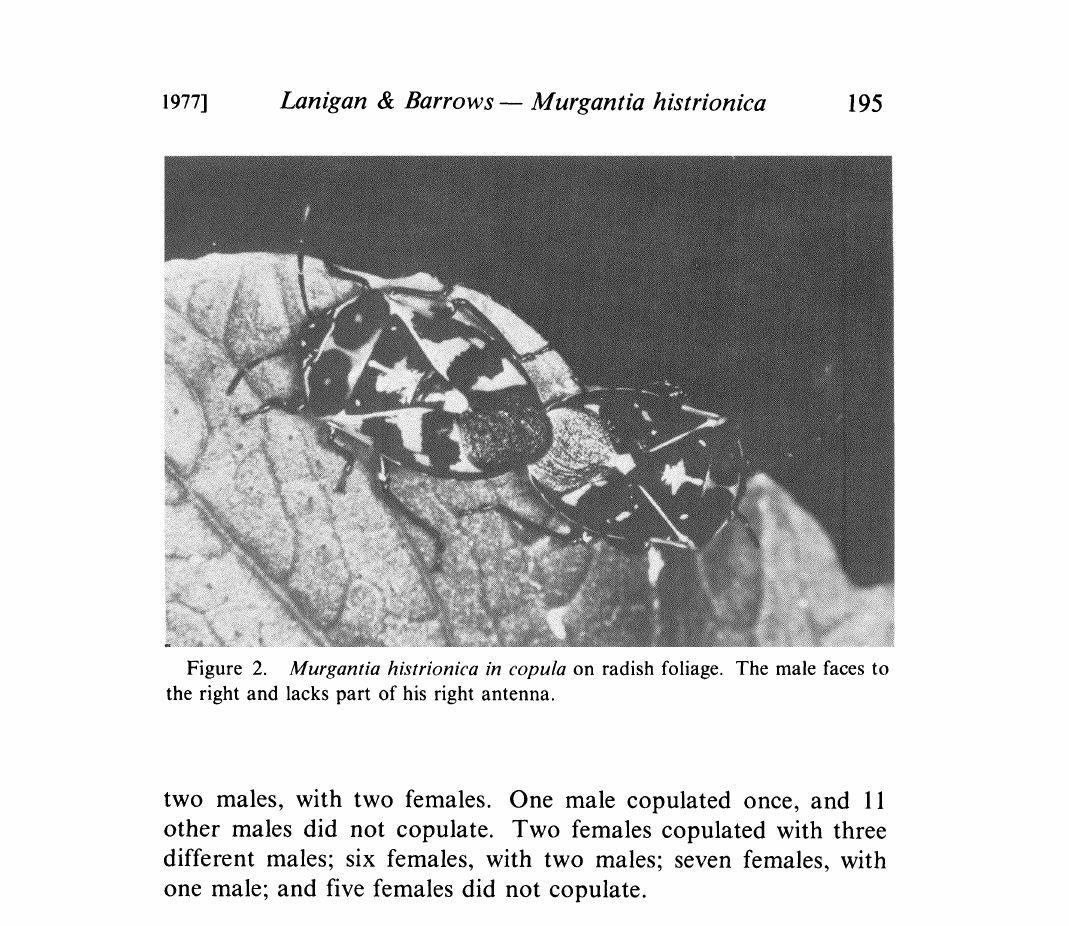
two males, with two females. One male copulated once, and 11 other males did not copulate. Two females copulated with three different males; six females, with two males; seven females, with one male; and five females did not